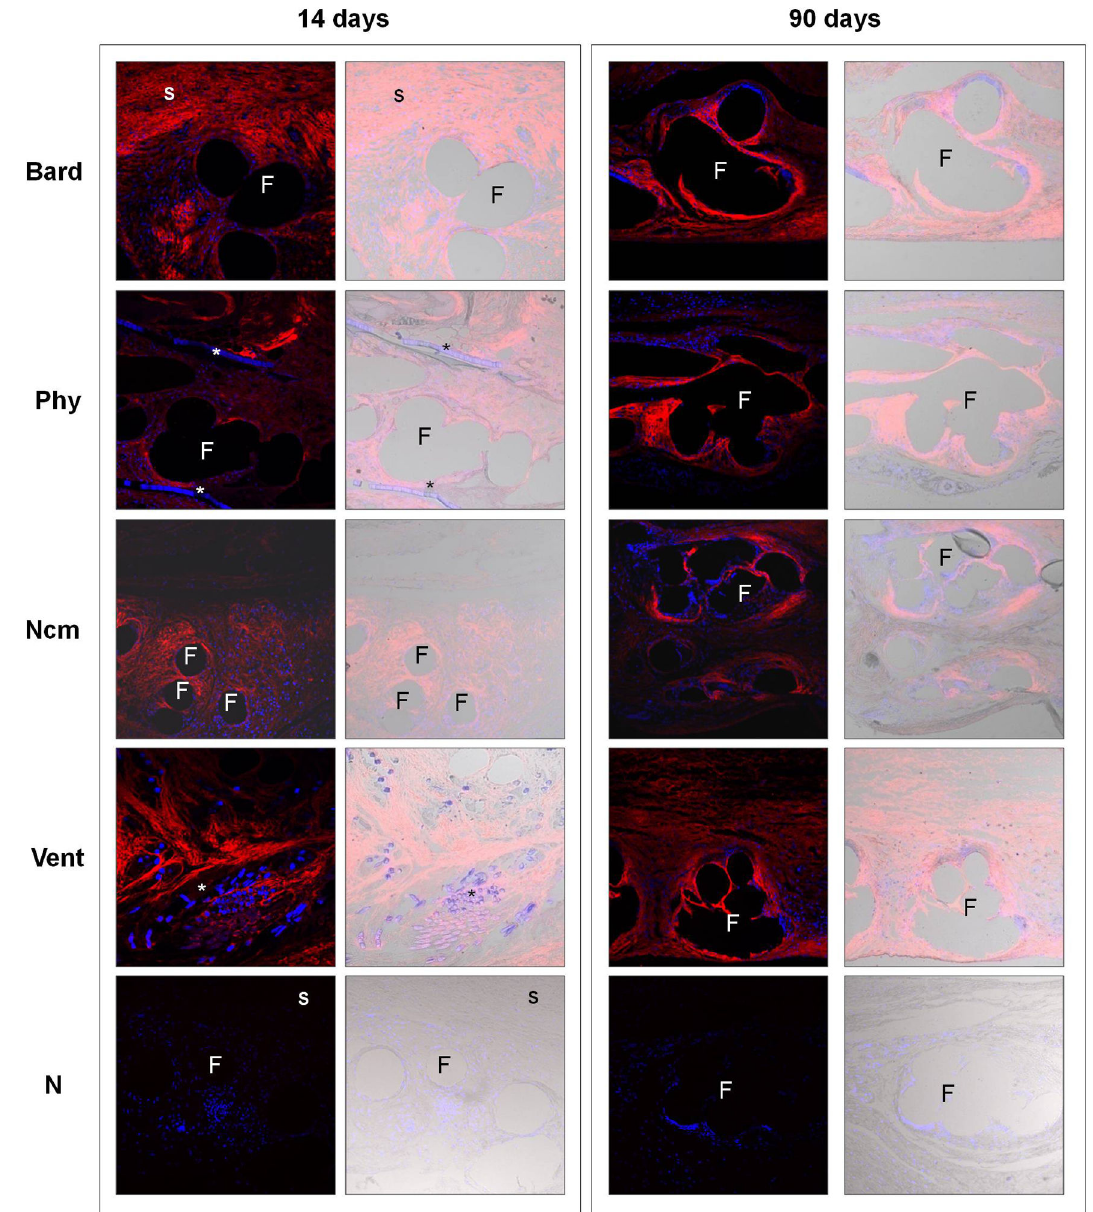
Figure 3. Collagen type I expression. Immunofluorescence detected for collagen type I at 14 and 90 days postimplant (left panel). N=negative controls; Bard mesh TM (Bard) 14 days and Physiomesh TM (Phy) 90 days. Neoformed collagen appears red and cell nuclei (stained with DAPI) appear blue. In the DIC images, the biomaterial appears translucent (right panel). Confocal light microscopy (200x). Subcutaneous tissue (s), prosthetic filaments (F), polyglycolic acid or polyglecaprone (*). doi: